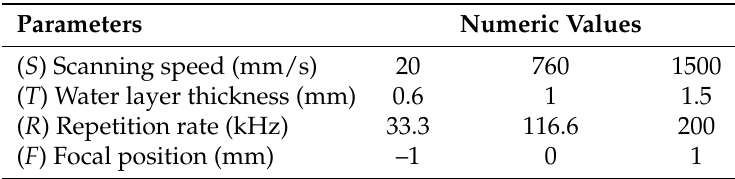
Table 1. Parameters varied and their